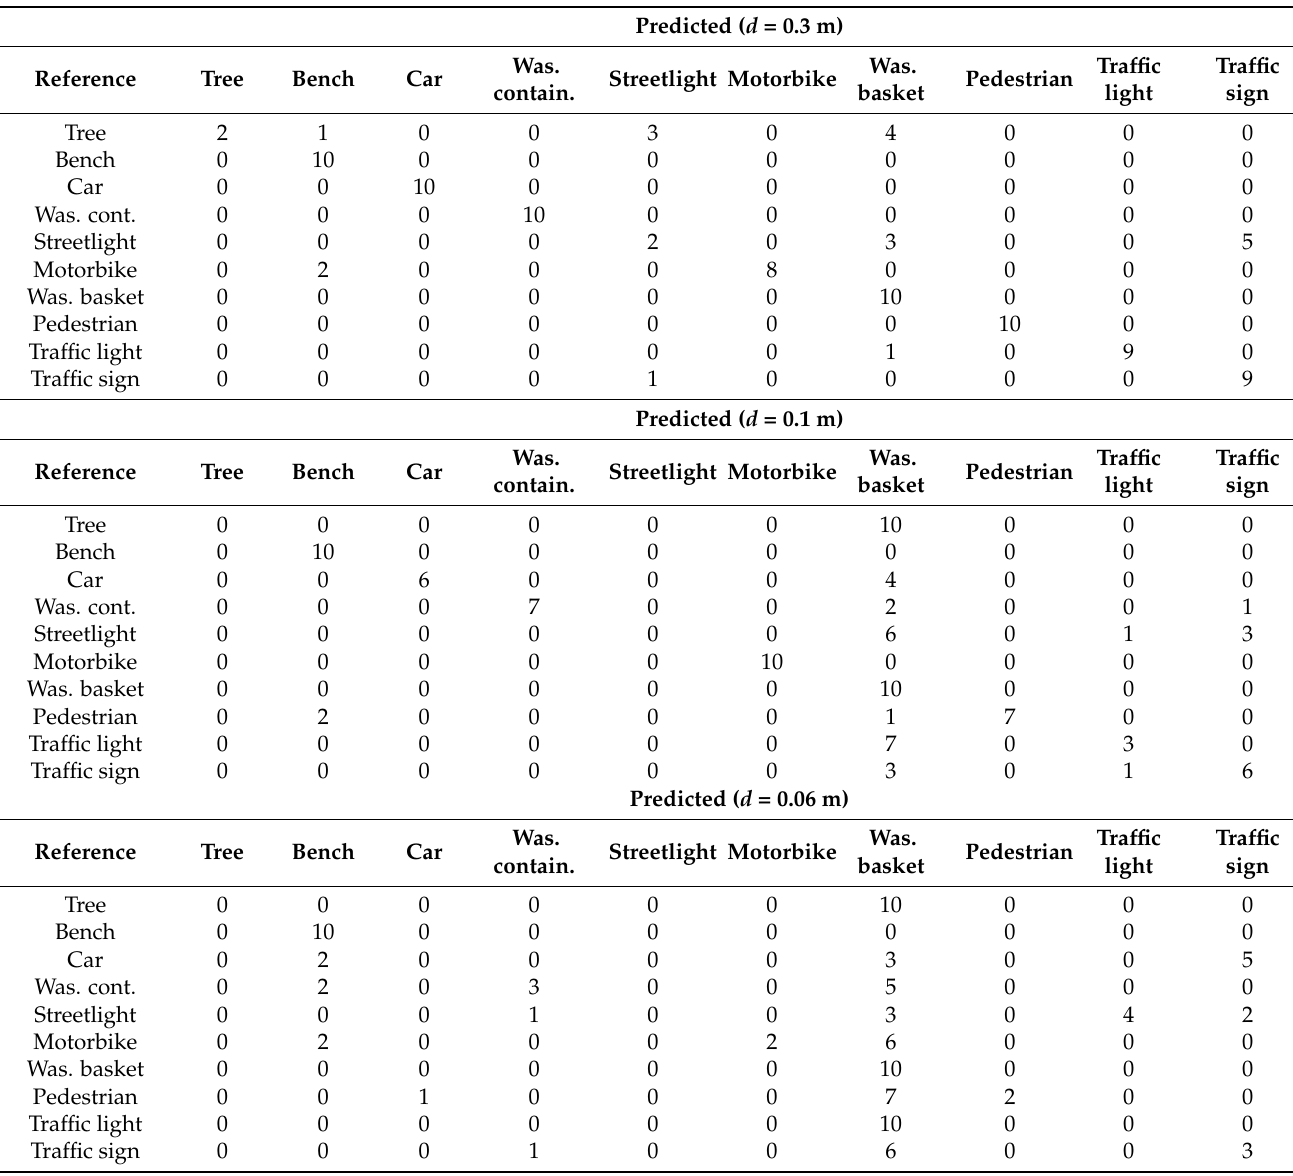
Table 8. Confusion matrices for noise evaluation with d = 0.3 m, d = 0.1 m, and d = 0.06